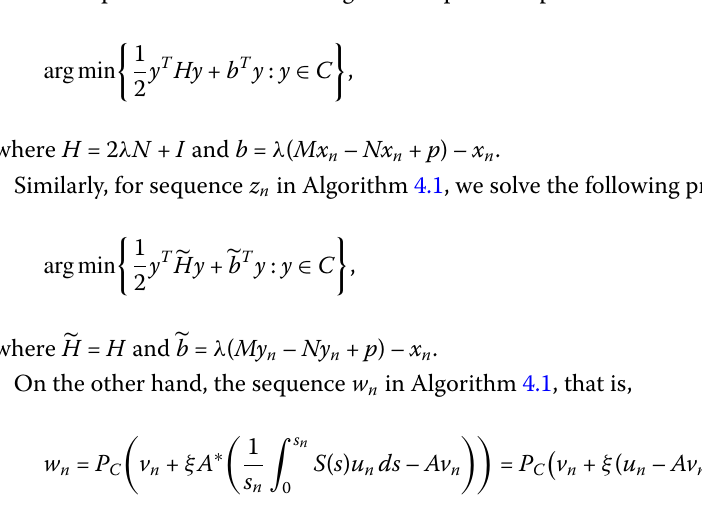
Algorithm 4.1, we need to solve the following optimization